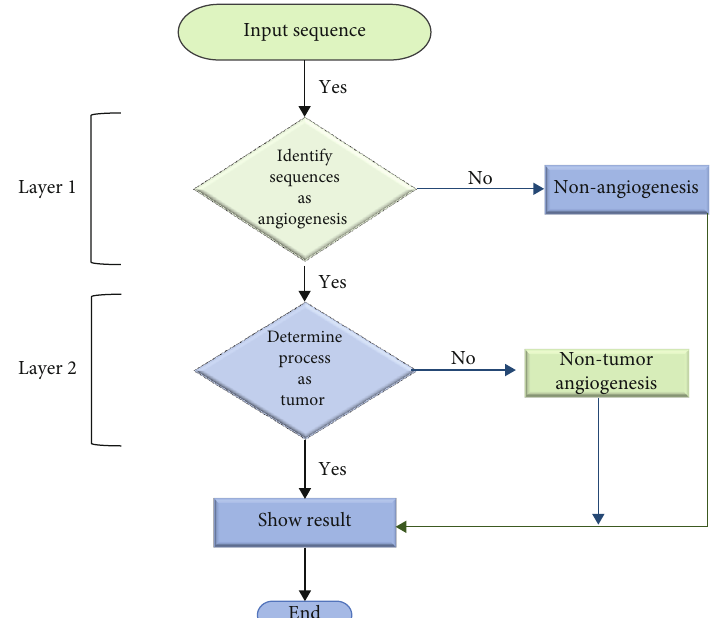
Figure 1: Flowchart of the proposed system.